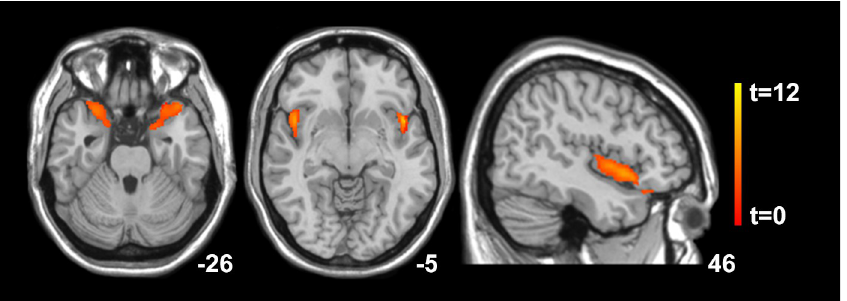
Fig 1. Statistical parametric mapping ( t ) intensity projection maps showing areas of significant decreases of grey matter volume (color code, yellow to orange) in a cohort of people with multiple sclerosis compared to healthy control subjects at baseline rendered on to a stereotactically normalized MRI scan in MNI space (z = -26 and -5; x = 46). The right side of the image corresponds to the right side of the brain. group of HCs, significant increases in GMV were found in the left insula following the English training intervention (p = 0.039; Table 4; Fig 2B). Spatial normalization-adjusted grey matter volume before and after the L2 training on the individual level are detailed in S2 Table and S1 Fig. GMV increase of the right hippocampus and parahippocampus was significantly correlated to the improvement in vocabulary knowledge in pwMS (p = 0.031; corrected at cluster level; Table 4; Fig 2C; S2 Fig); no correlations between listening comprehension as well as speaking fluency scores and MRI signal changes were evident. In HCs, no significant correlations were found between GMV changes and L2 proficiency scores.